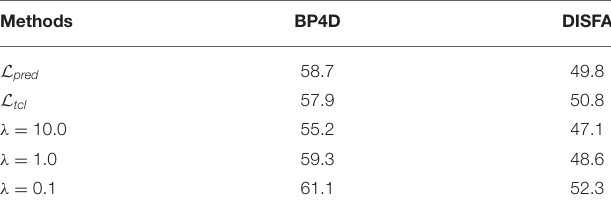
TABLE 3 | Ablation studies on the BP4D and DISFA datasets.